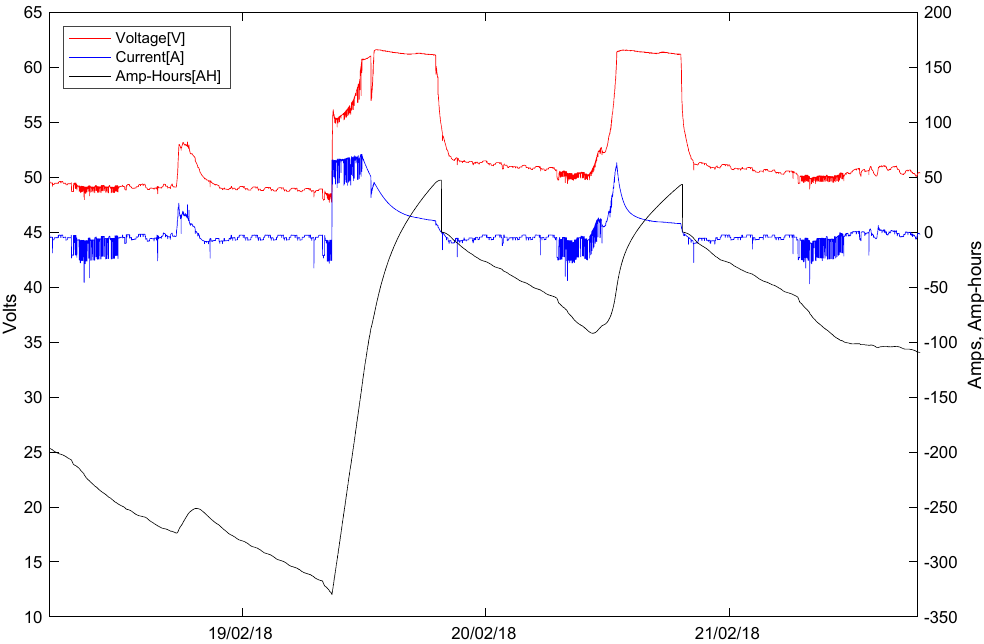
Figure 7. Automatic genset start on the morning of February 19. Extended solar-based absorption CV charging (no reduced float CV), increased charge acceptance and substantially increased working capacity as confirmed in Figure 3.